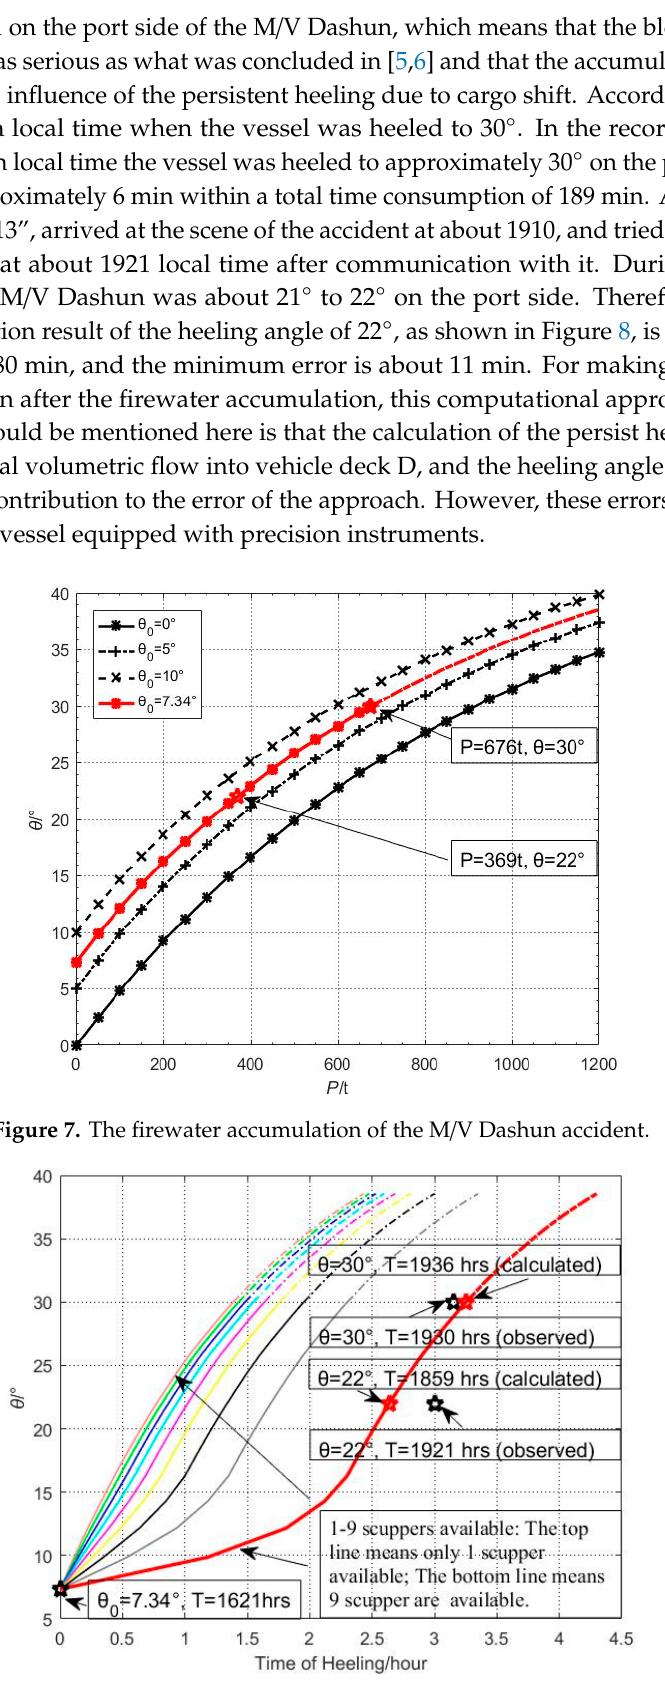
Figure 8. The heeling time of the M/V Dashun accident after the blockage of 2 of 11 scuppers.